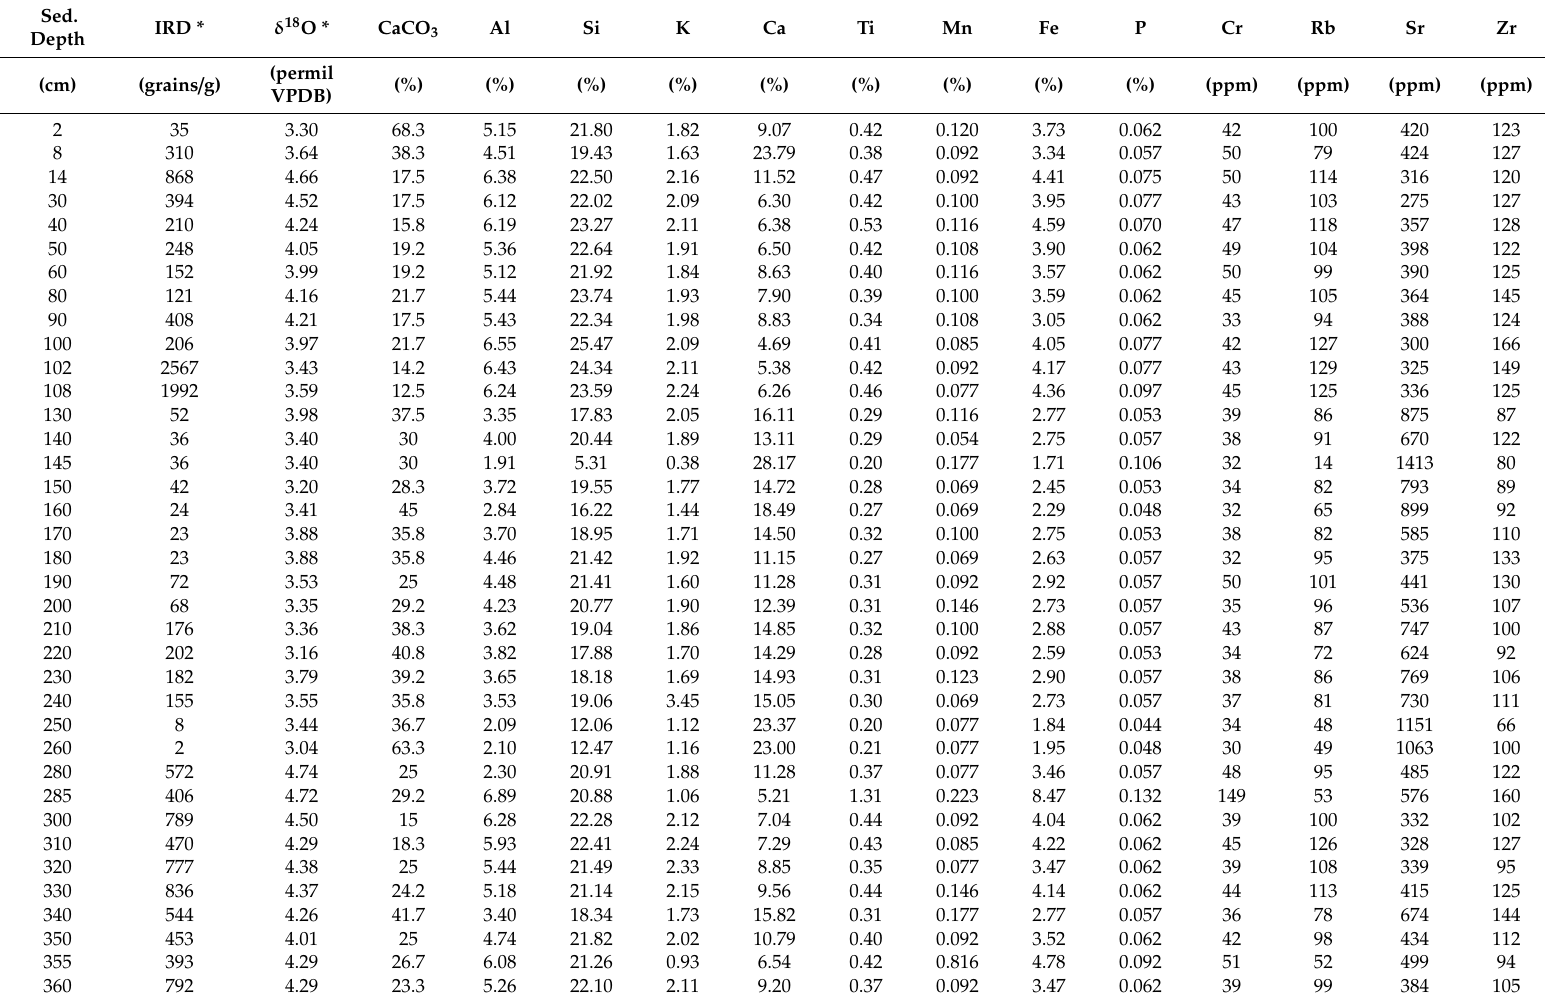
Table 2. Counts of IRD, δ 18 O, contents of CaCO 3, major and trace elements in sediment core AMK-4493, the Gloria Drift. Sed.